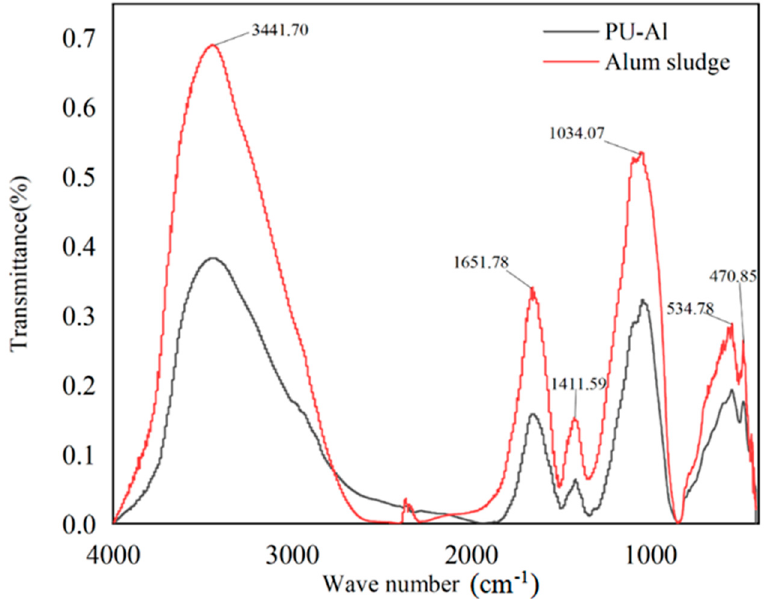
Figure 2. FTIR of PU-AL and alum sludge.